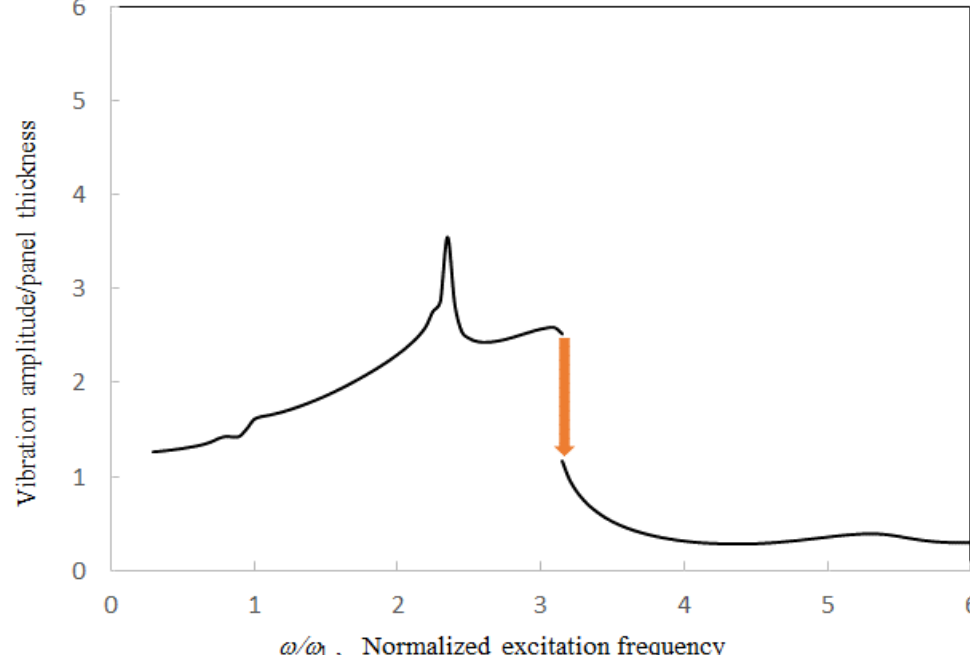
Figure 8. Vibration amplitude ratio versus normalized excitation frequency for various duct lengths (number of structural modes = 2, number of acoustic modes = 4, γ = 2, θ = 0, l = 3 a ; the orange arrow represents the “jump phenomenon”).